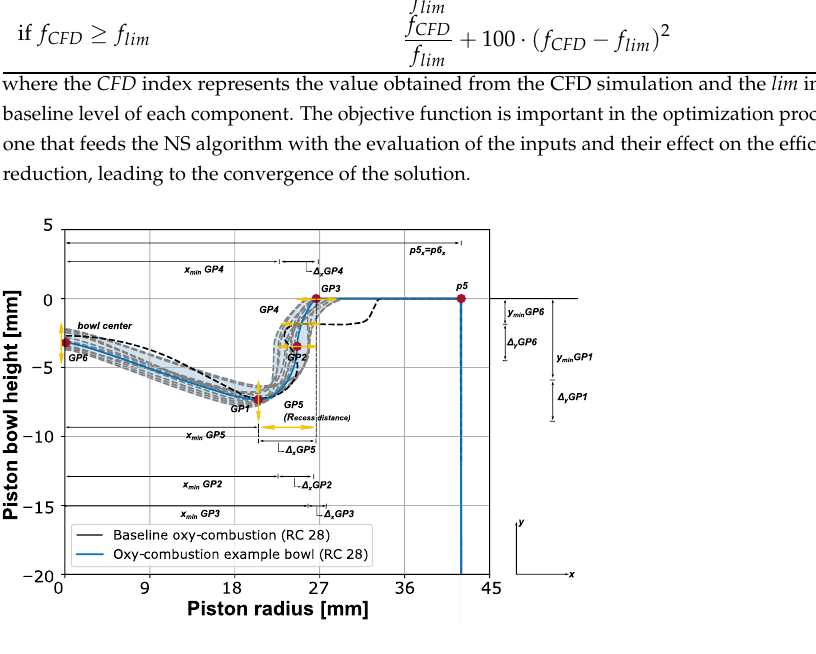
Figure 4. Example of bowls obtained for the combustion chamber